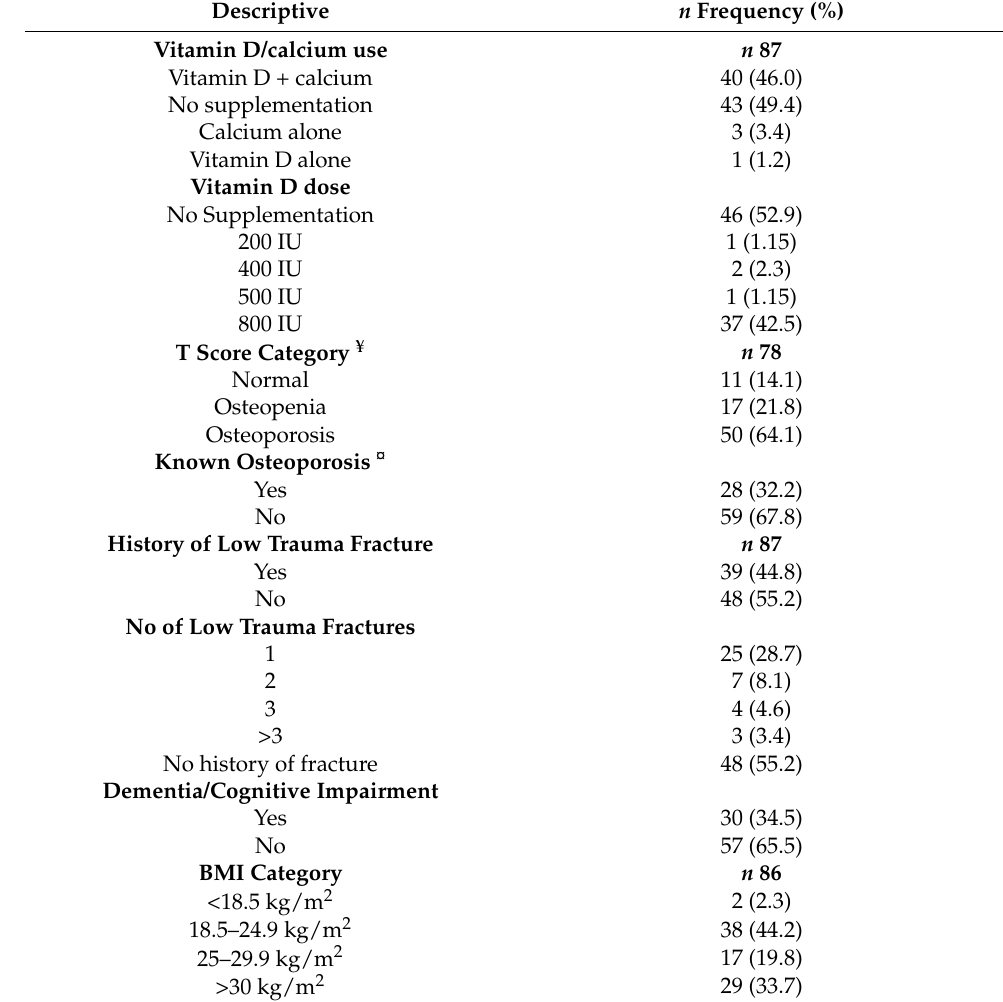
Table 1. Supplement use and musculoskeletal health of care home residents.